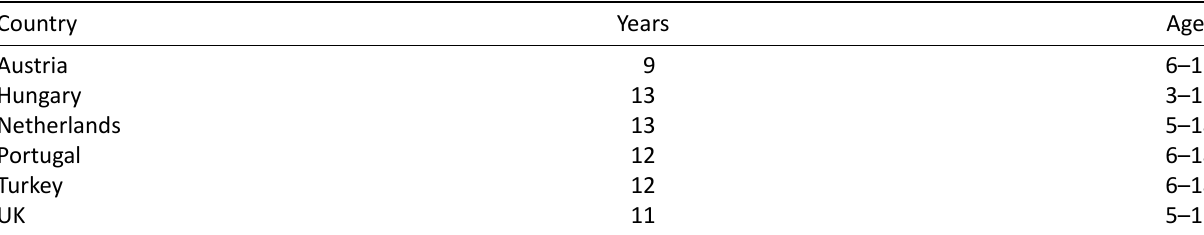
Table 1. Years of compulsory education.